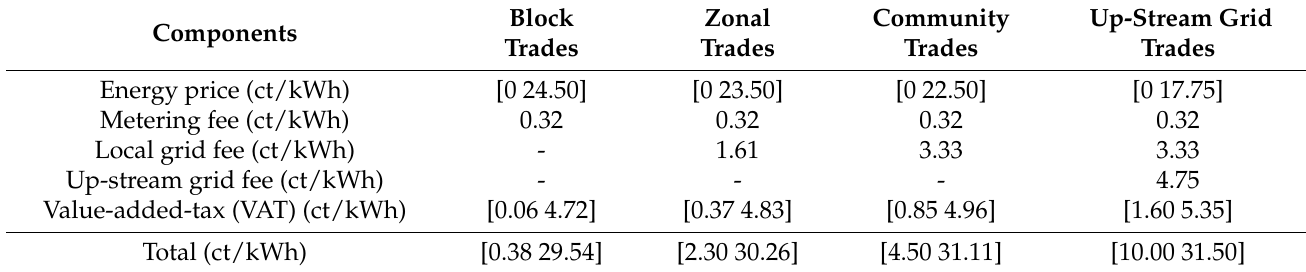
Table 3. Price components for hierarchical community and with the up-stream